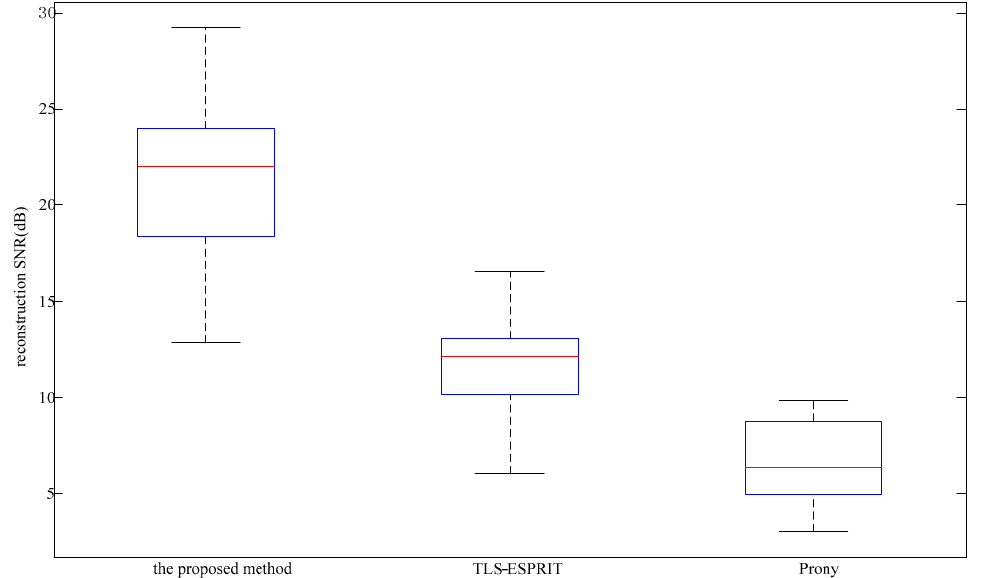
Figure 13. The SNR rec with different methods.